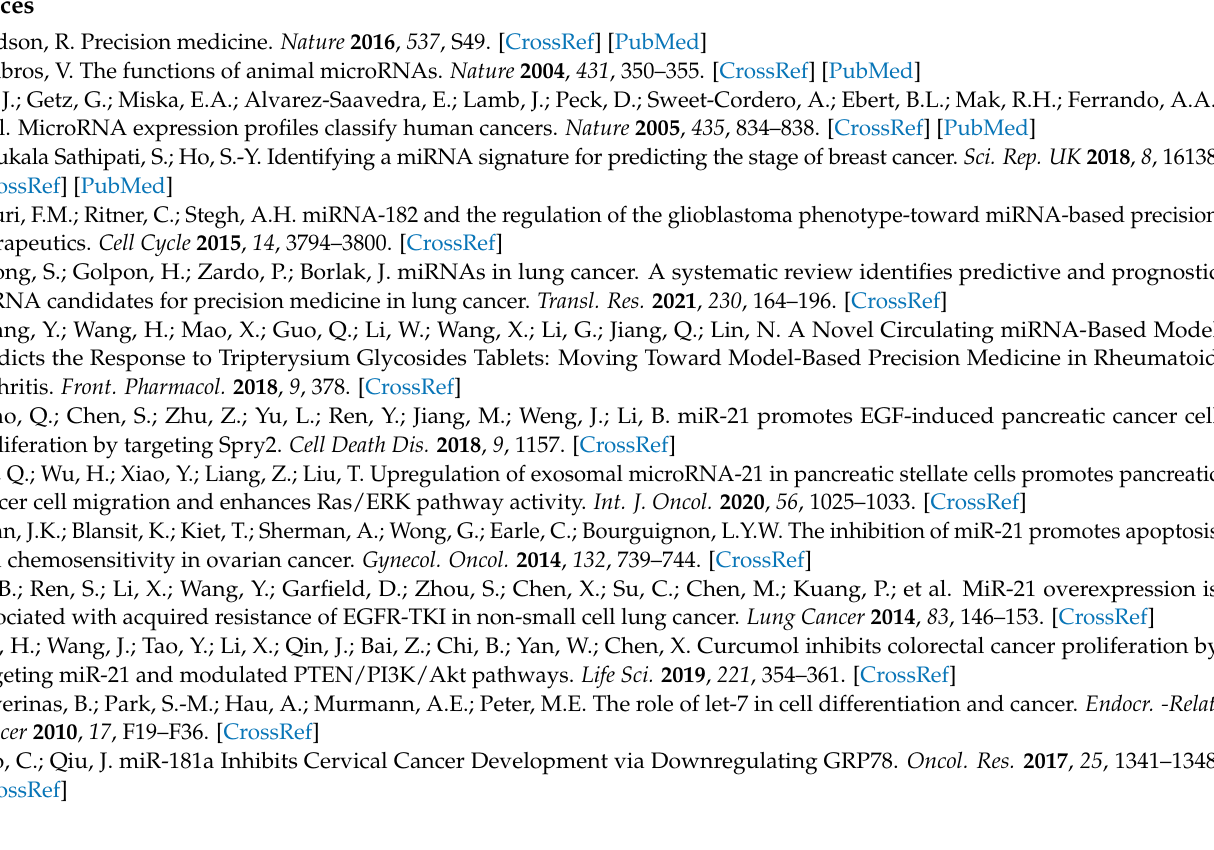
Table S1: DNA sequence and peptide